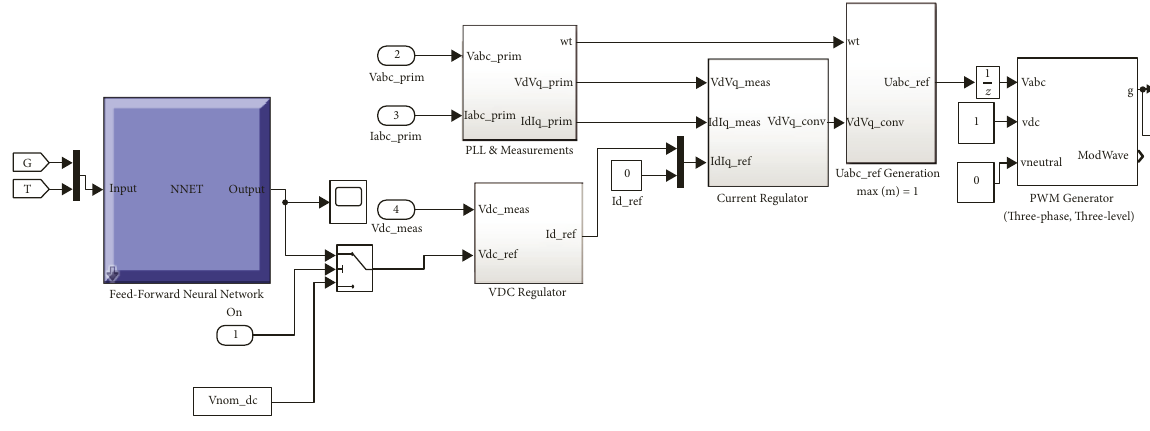
Figure 10: ANN trained with PSO algorithm control circuit. Table 1: Technical specifications of the 325W PV module from JA Solar